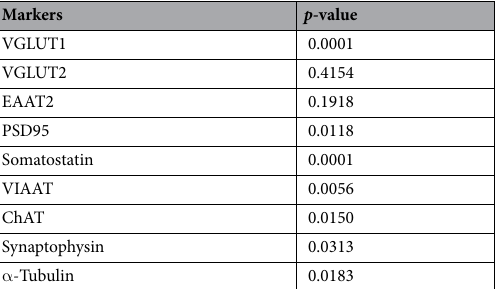
Table 2. Kruskal-Wallis test output from the analysis of synaptic markers vs. CDR